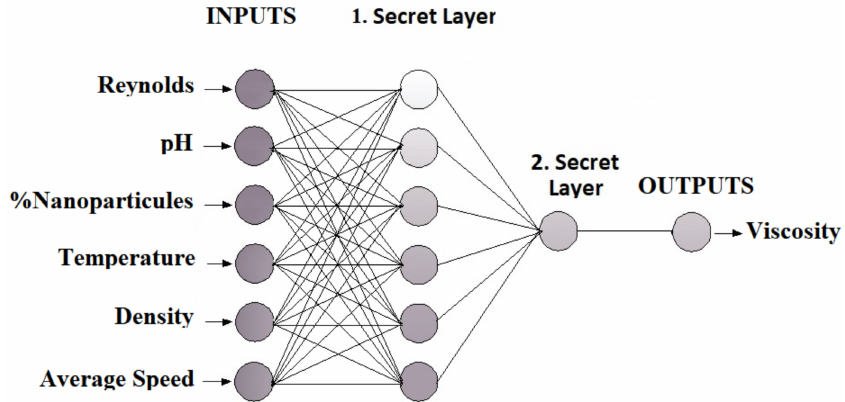
Figure 5. The network structure of multilayer perceptron